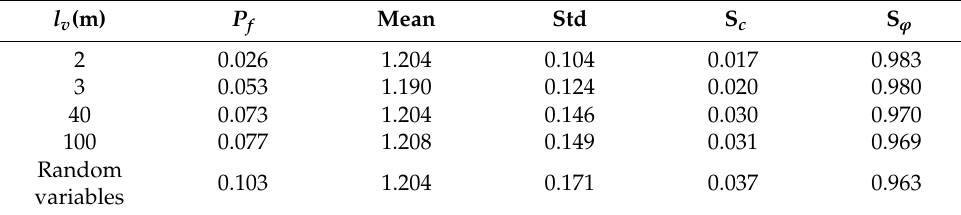
Table 5. Probabilistic results comparison with different values of autocorrelation length.